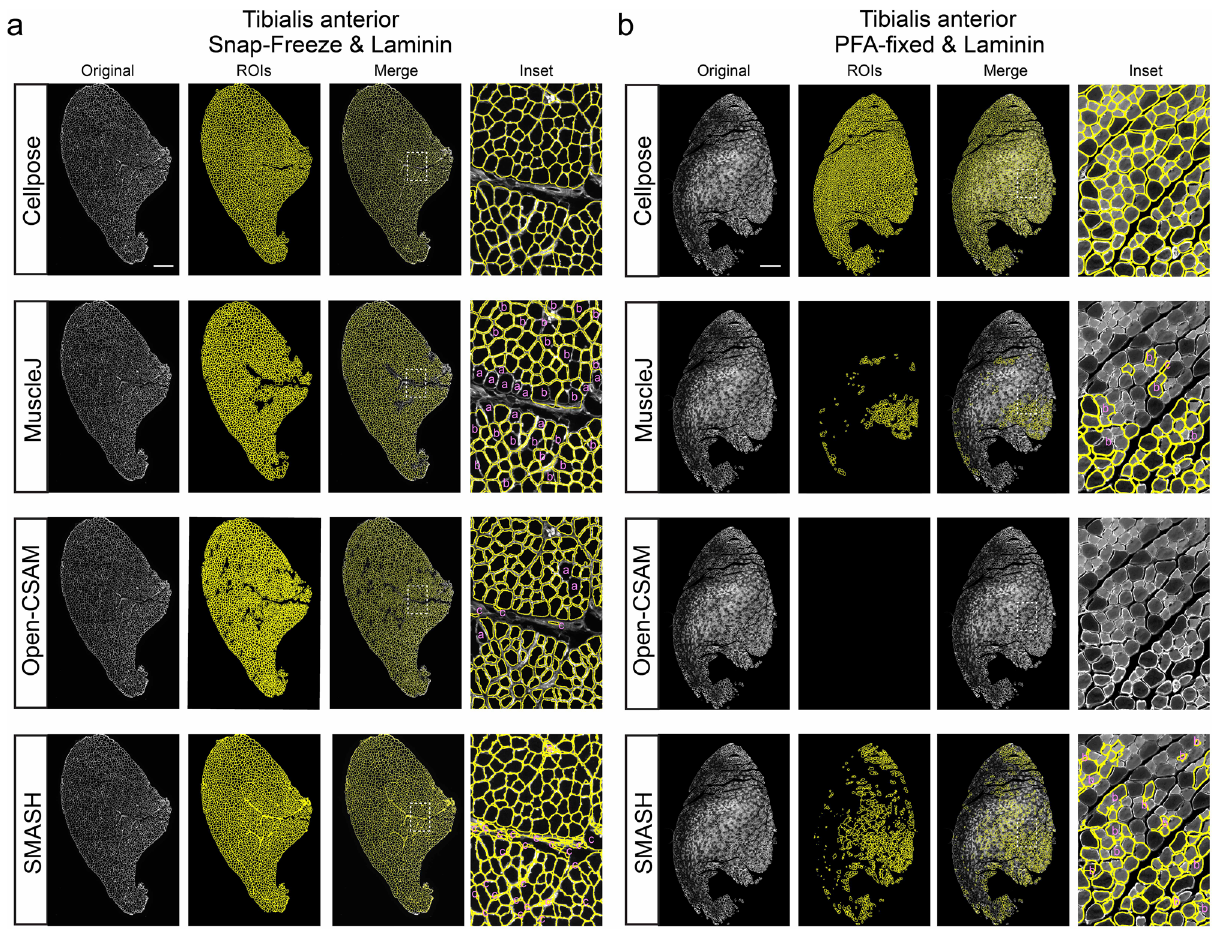
Figure 3. Segmentation comparison between Cellpose and different software. Snap-frozen ( a ) and PFA-fixed ( b ) TA sections were stained for Laminin and segmented by Cellpose, MuscleJ, Open-CSAM and SMASH as indicated. Original image on the left and segmentation results labeled as ROIs. Inserts on right represent magnified areas as indicated by boxes in the merged image. Segmentation errors are labeled as missed fibers ( a ), mis-segmented fibers ( b ) and false-positive fibers ( c ). Scale bar, 500